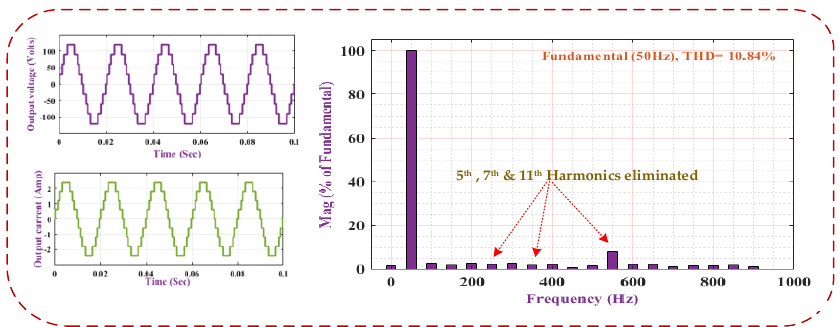
Figure 12. Seven-level outputs and the harmonic profile.